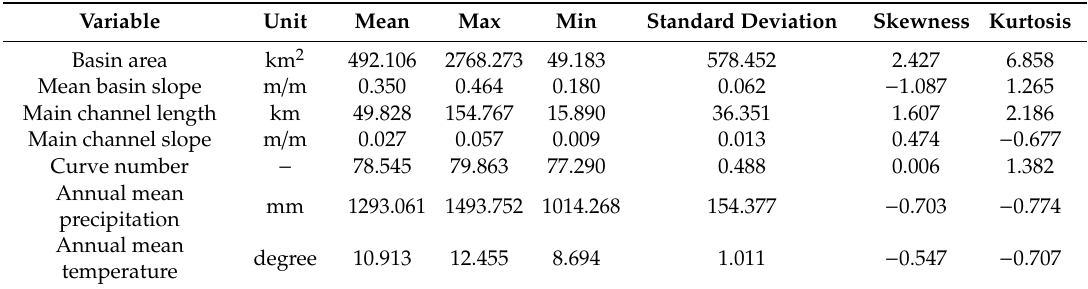
Table 2. Descriptive statistics of the hydrological, physiographical, and meteorological variables for the 33 watersheds that were used in this study.